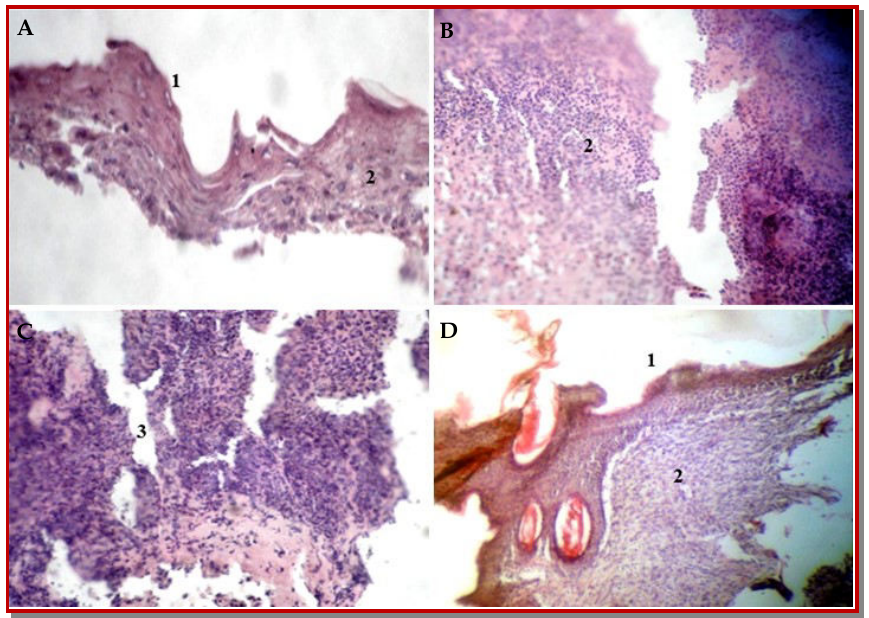
Figure 2: (A) Histopathology of S. incanum treated group showing intact epidermis and tissue regeneration. (B) Vehicle control showing ulceration and inflammation indicated by neutrophils. (C) Negative control showing central inflammation. (D) Positive control showing intact epidermis and tissue regeneration; 1. Regenerated epidermis 2. Granulation tissue 3. Necrotic tissue and